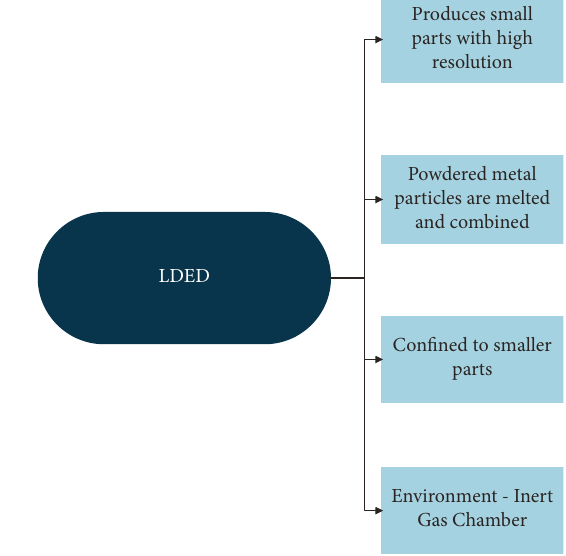
Figure 6: Characteristics of EBAM process. Figure 7: Characteristics of LDED process.